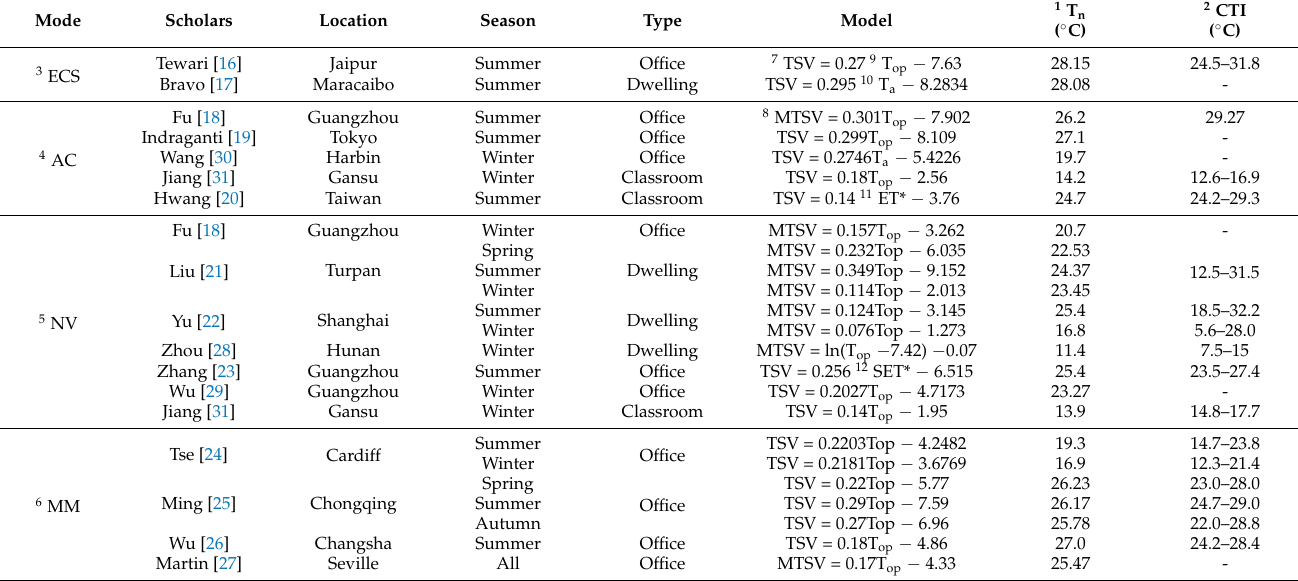
Table 1. Summary of previous thermal comfort studies with different